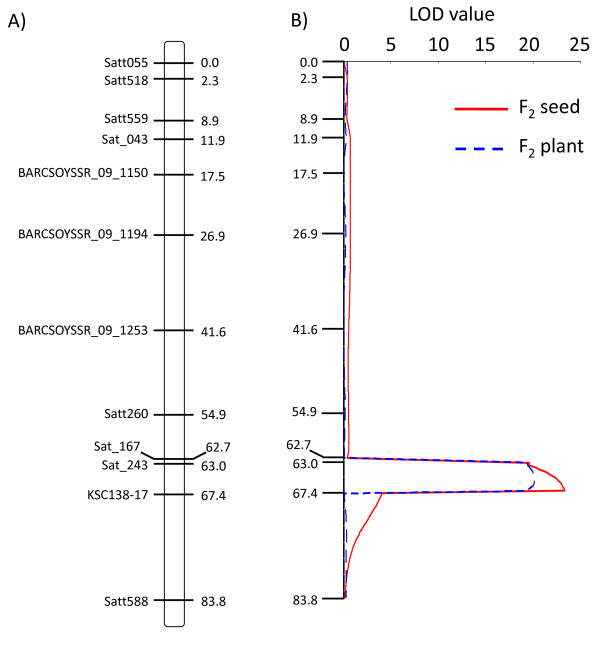
QTL for high α-tocopherol concentration on chromosome 9. (A). Graphical overview of the genetic map on chromosome 9. A vertical thick bar indicates soybean chromosome 9. Molecular markers and genetic distances (Kosambi cM) are depicted at the right and left sides of chromosome 9, respectively. (B). LOD value profile from MQM mapping of α-tocopherol concentration on chromosome 9. Y-axis corresponds to the genetic map with distances expressed in (A). Horizontal line corresponds to the LOD value. Solid red and dashed blue lines indicate the LOD scores calculated using F2 seed and F2 plant population, respectively.